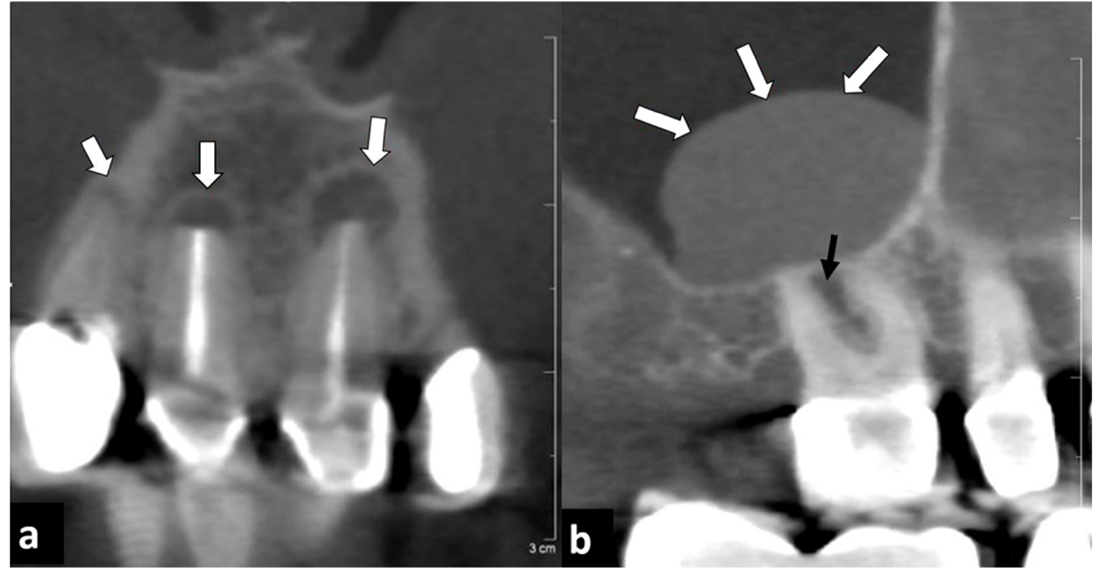
Figure 1. Forty-one year old male patient who underwent endodontal therapy. ( a ) Paracoronar reconstruction showed periapical resorptions and osteolysis at teeth 21, 11, and less pronounced also at tooth 12 (arrows). ( b ) Parasagittal reconstruction of the upper right jaw showed a polypoid mucosal swelling at the bottom of the right maxillar sinus (white arrows), probably induced by an interradicular resorption at tooth 16 (black